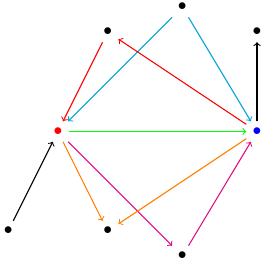
Figure 3. Directed triangles and their different impact on